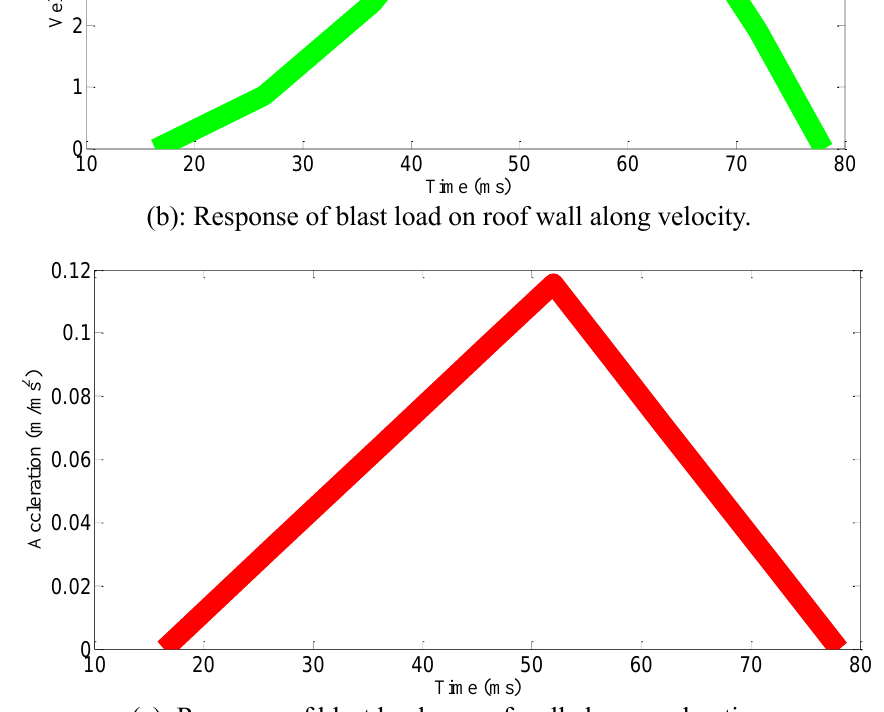
(c): Response of blast load on roof wall alongacceleration. Fig. 8. Response of blast load on roof with respect to